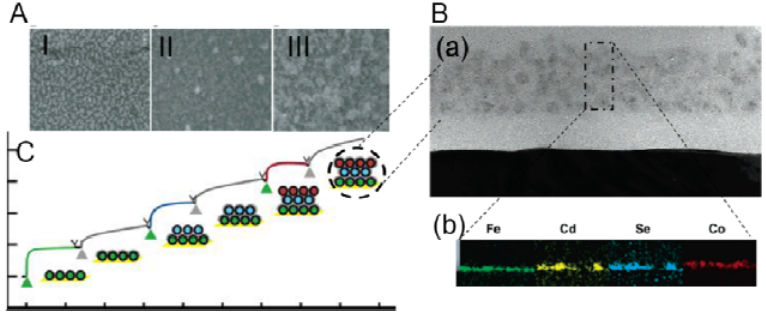
Figure 6. Layer by layer (LbL) assembly of Fe, Cd, Se and CO filled ferritin-TBP1 molecules: (A) SEM images of titania surface (I), after decoration with Ferritin-TBP1 (II), and after biomineralization of silica interlayer (III). (B) intersection of the constructed LbL (a), EDS mapping of metal filled ferritin-TBP1 after LbL assembly (b), (C) The QCM-D signal of the construction of ferritin-TBP1 and silica interlayers. Adapted with permission from [82]. Copyright 2009 American Chemical